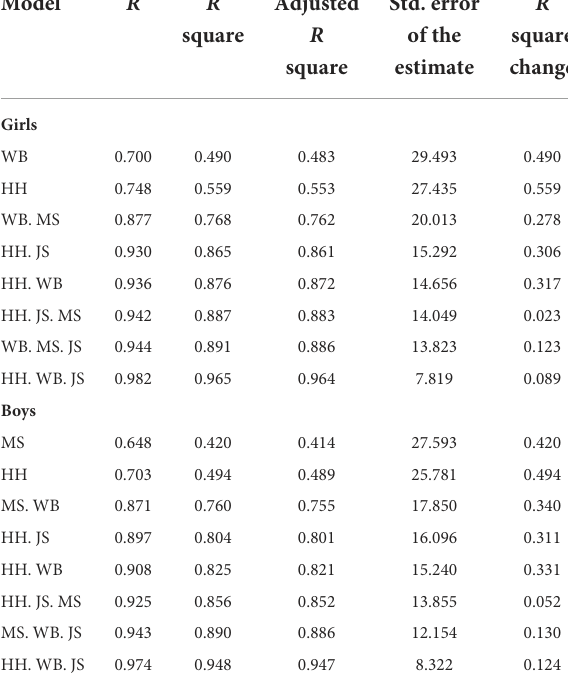
TABLE 8 Data from stepwise linear regression declared among 12-year aged subject of both sexes. Model